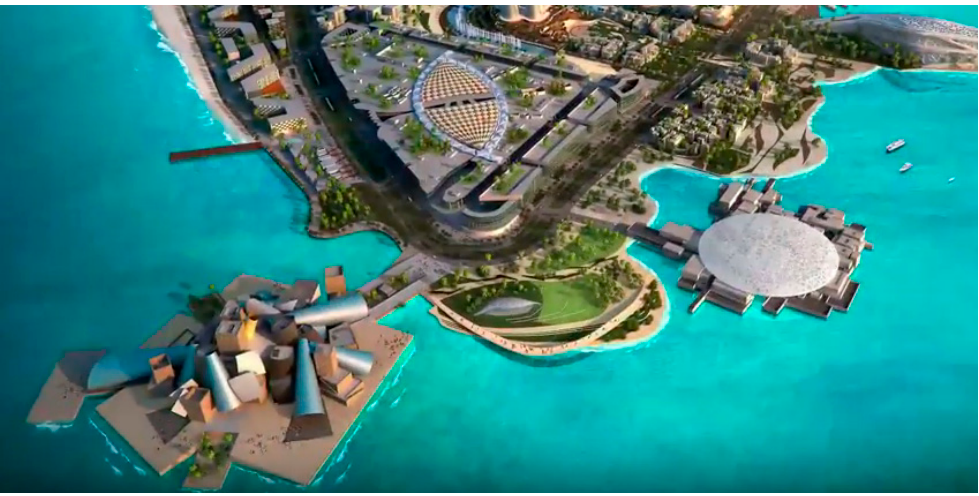
Figure 2. Concept Master Plan of Saadiyat Cultural District (courtesy Tourism Development & Investment Company).